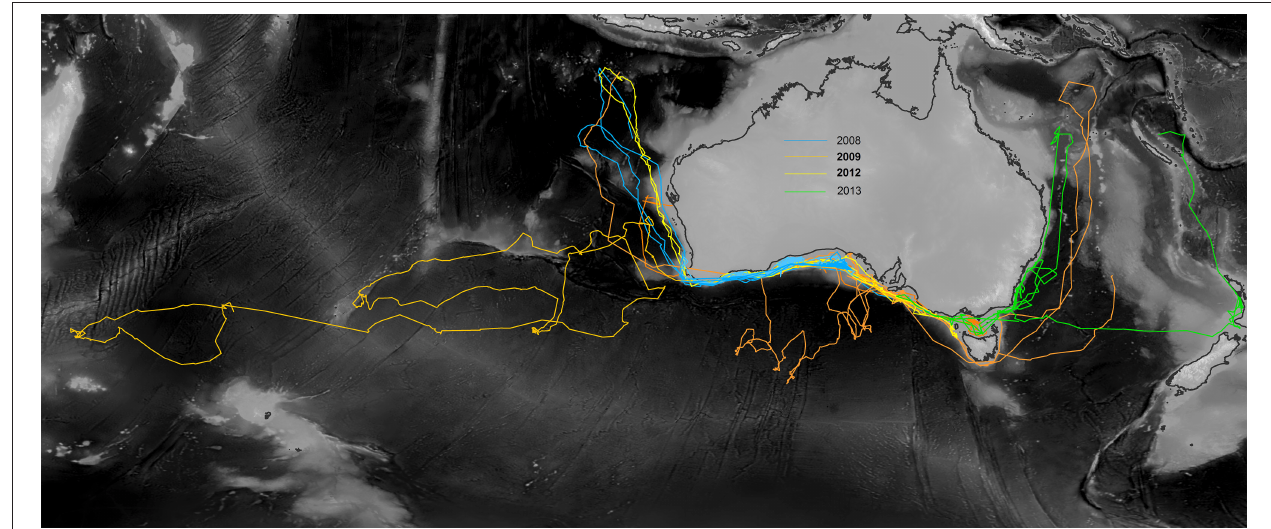
FIGURE 2 | CRAWL model fits to tag data showing the spatial range occupied by shortfin mako over 249–672 days. Individuals were tagged in continental shelf and slope waters of southern Australia between 2008 and